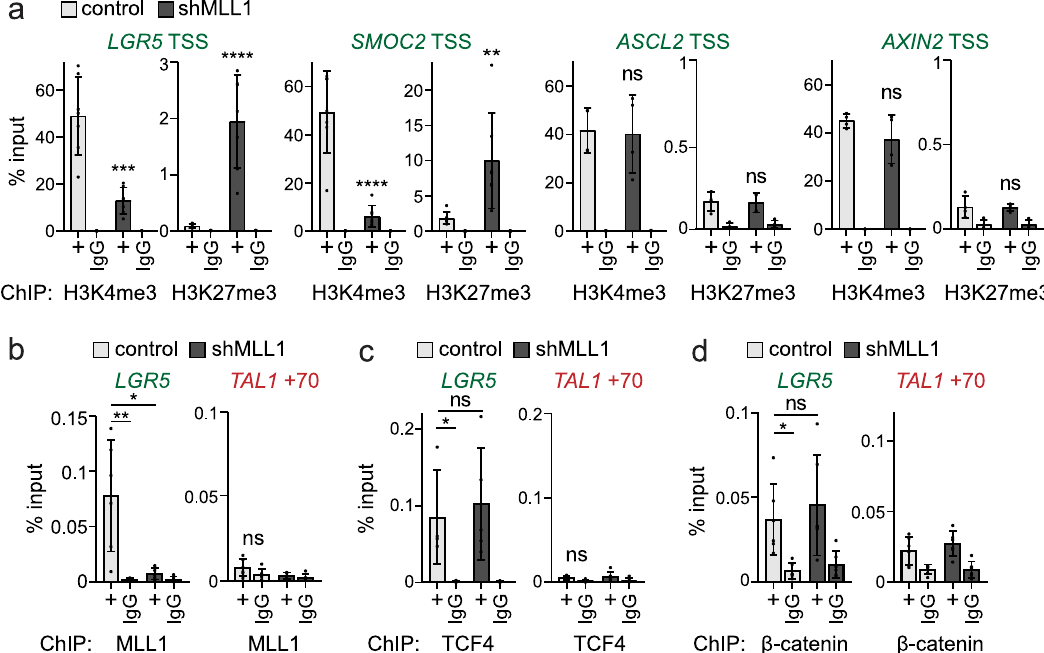
Fig. 5 Mll1 directly regulates intestinal stem cell genes. a ChIP for H3K4me3 and H3K27me3 at TSSs of LGR5 , SMOC2 ( n = 7 samples derived from two biologically independent cell clones over four independent experiments), ASCL2 and AXIN2 ( n = 4 samples derived from two biologically independent cell clones over two independent experiments) in non-induced control (light gray columns), and 11d doxycycline-induced shMLL1 Ls174T cells (black columns), represented as % input. Two-tailed unpaired t -test, signi fi cance calculated for control versus shMLL1, LGR5 TSS *** p = 0.0002, **** p < 0.0001; SMOC2 TSS **** p < 0.0001, ** p = 0.0082. b ChIP for MLL1 in non-induced control (light gray columns) and 6d doxycycline-induced shMLL1 human Ls174T cells (black columns) at the LGR5 promoter, negative control region + 70 kb downstream of the TAL1 promoter, represented as % input, n = 6 control and n = 5 shMLL1 samples derived from two biologically independent cell clones over four independent experiments. Two-tailed unpaired t -test, signi fi cance calculated for control versus shMLL1 and IgG, * p = 0.0129, ** p = 0.0042. ChIP for TCF4 ( c ) and β -catenin ( d ) at the LGR5 promoter in non-induced control (light gray columns) and 6d doxycycline-induced shMLL1 human Ls174T cells (black columns), negative control region TAL1 + 70, represented as % input, n = 5 (TCF4) and n = 6 samples ( β -catenin) derived from two biologically independent cell clones over three independent experiments. Two-tailed unpaired t -test, signi fi cance calculated for control versus shMLL1 and IgG, TCF4 * p = 0.03, β -catenin * p = 0.02. All data are presented as mean values ± SD. Source data are provided as a Source Data fi